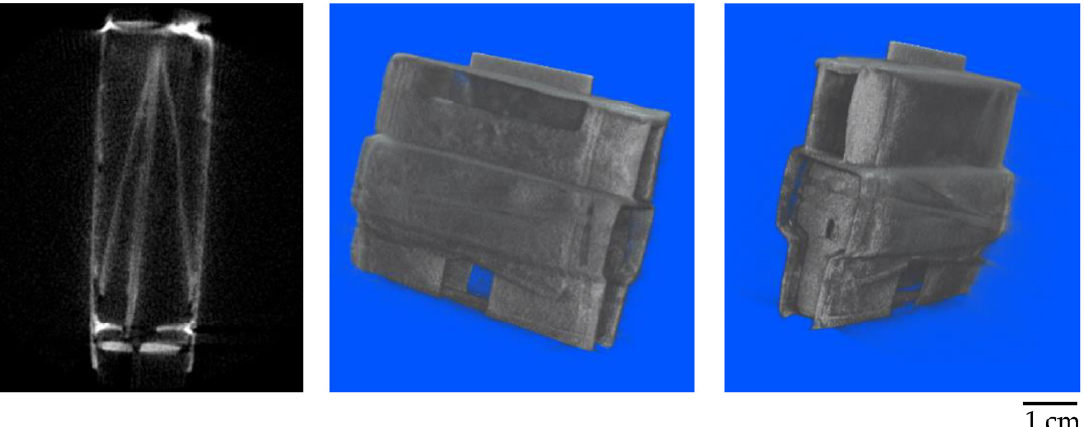
Figure 10. Results of first neutron computed tomography at 500 W, a tomographic slice and 3D views.